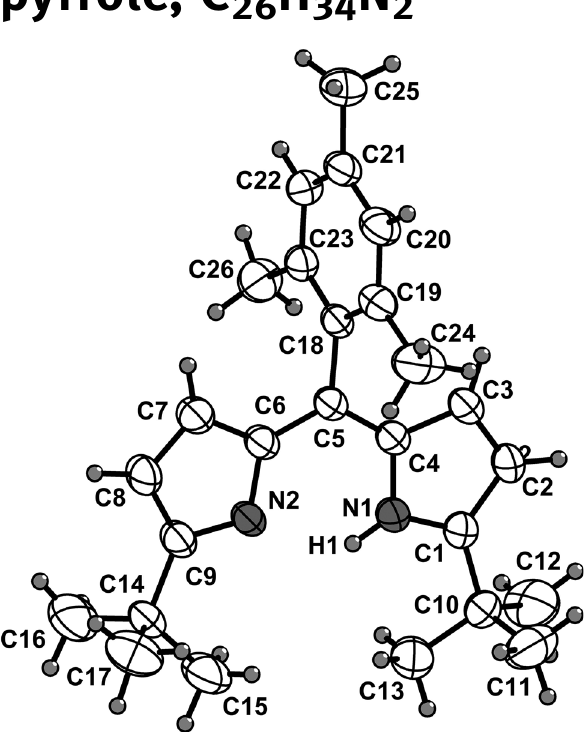
Figure 1: A view of the molecule. Displacement ellipsoids are drawn atthe50%probabilitylevelandHatomsareshownassmallspheres of arbitrary